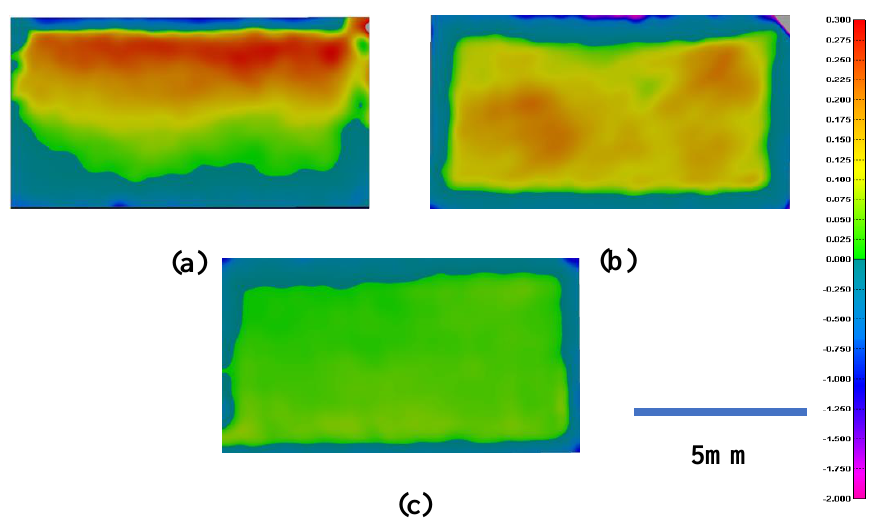
Figure 5. Bending deformation of the three specimens printed using three scan strategies: ( a ) the Z-shape scan strategy vertical to the inner structure; ( b ) the Z-shape scan strategy along the inner structure; and ( c ) the square-framed scan strategy.